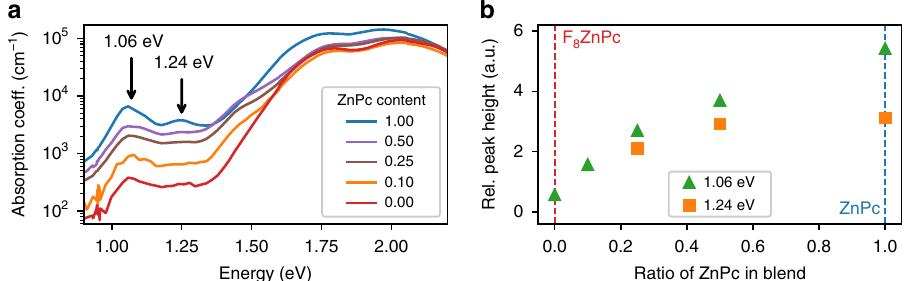
Fig. 1 Absorption spectra of p-doped fi lms. a Absorption spectra for different weight ratios of ZnPc:F 8 ZnPc p-doped at 0.05 molar ratio (MR) with F 6 - TCNNQ. The unmixed host of ZnPc with the dopant is marked as 1 : 00 and the unmixed case of F 8 ZnPc as host is marked as 0 : 00. b Relative peak height of the absorption features at 1.06 eV (1170 nm) and 1.24 eV (1000 nm), against the weight ratio of ZnPc in the host blend. These features are attributed to the ionised dopant. The peak heights are scaled relative to the intensity of the Q-band absorption peak at 1.77 eV (701